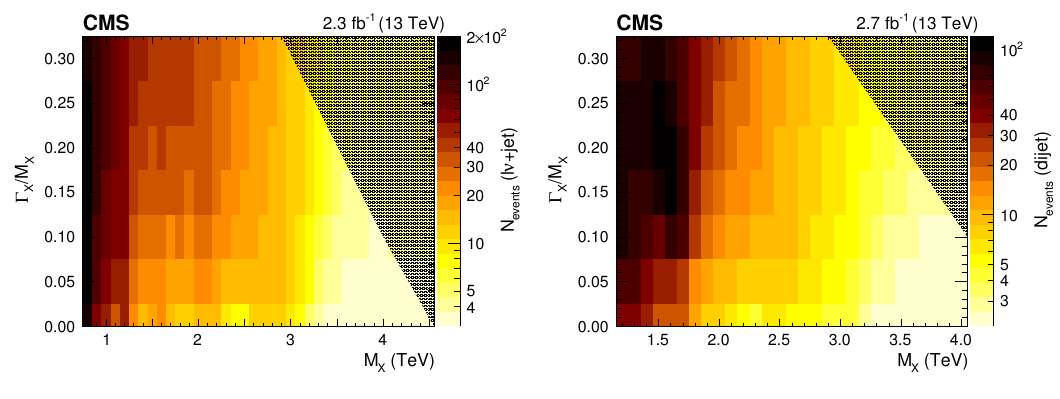
Figure 8 . Observed exclusion limits at 95% CL on the number of events for a WV ! ‘(cid:23) + jet (left) and a VV ! dijet (right) resonance, as a function of its mass and normalized width. The dark shaded area denotes the kinematic regime where the limit is valid only for the quark-antiquark annihilation